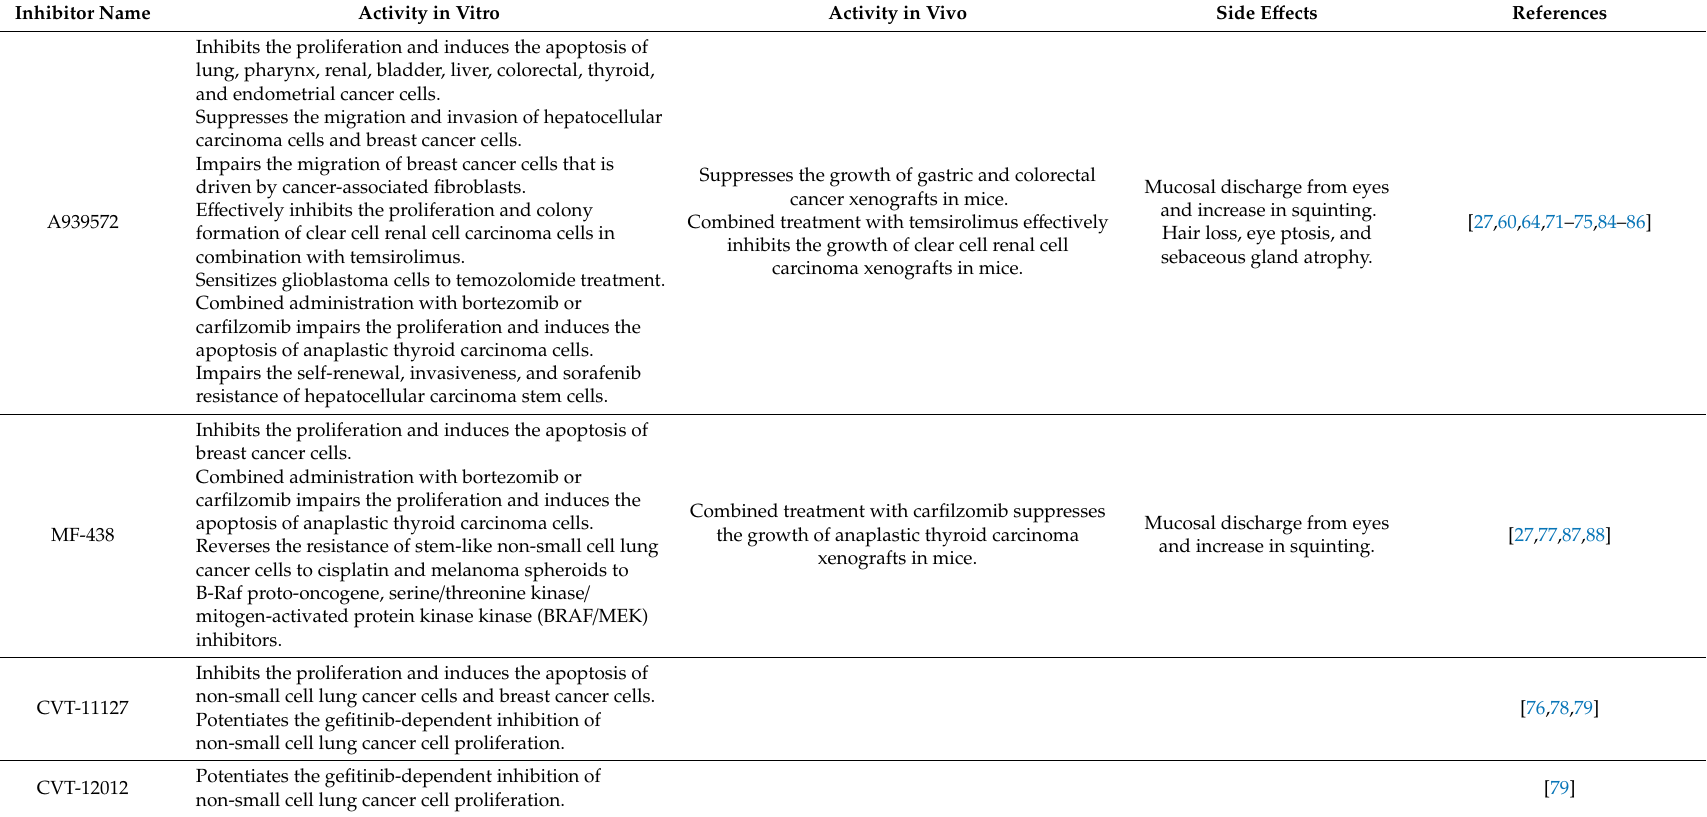
Table 1. Stearoyl-CoA desaturase 1 inhibitors with anticancer